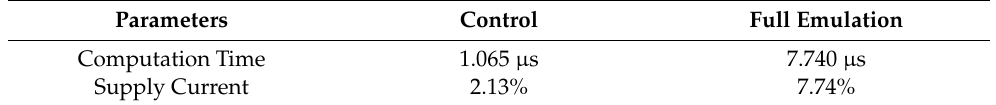
Table 2. Execution time calculated for proposed controller and